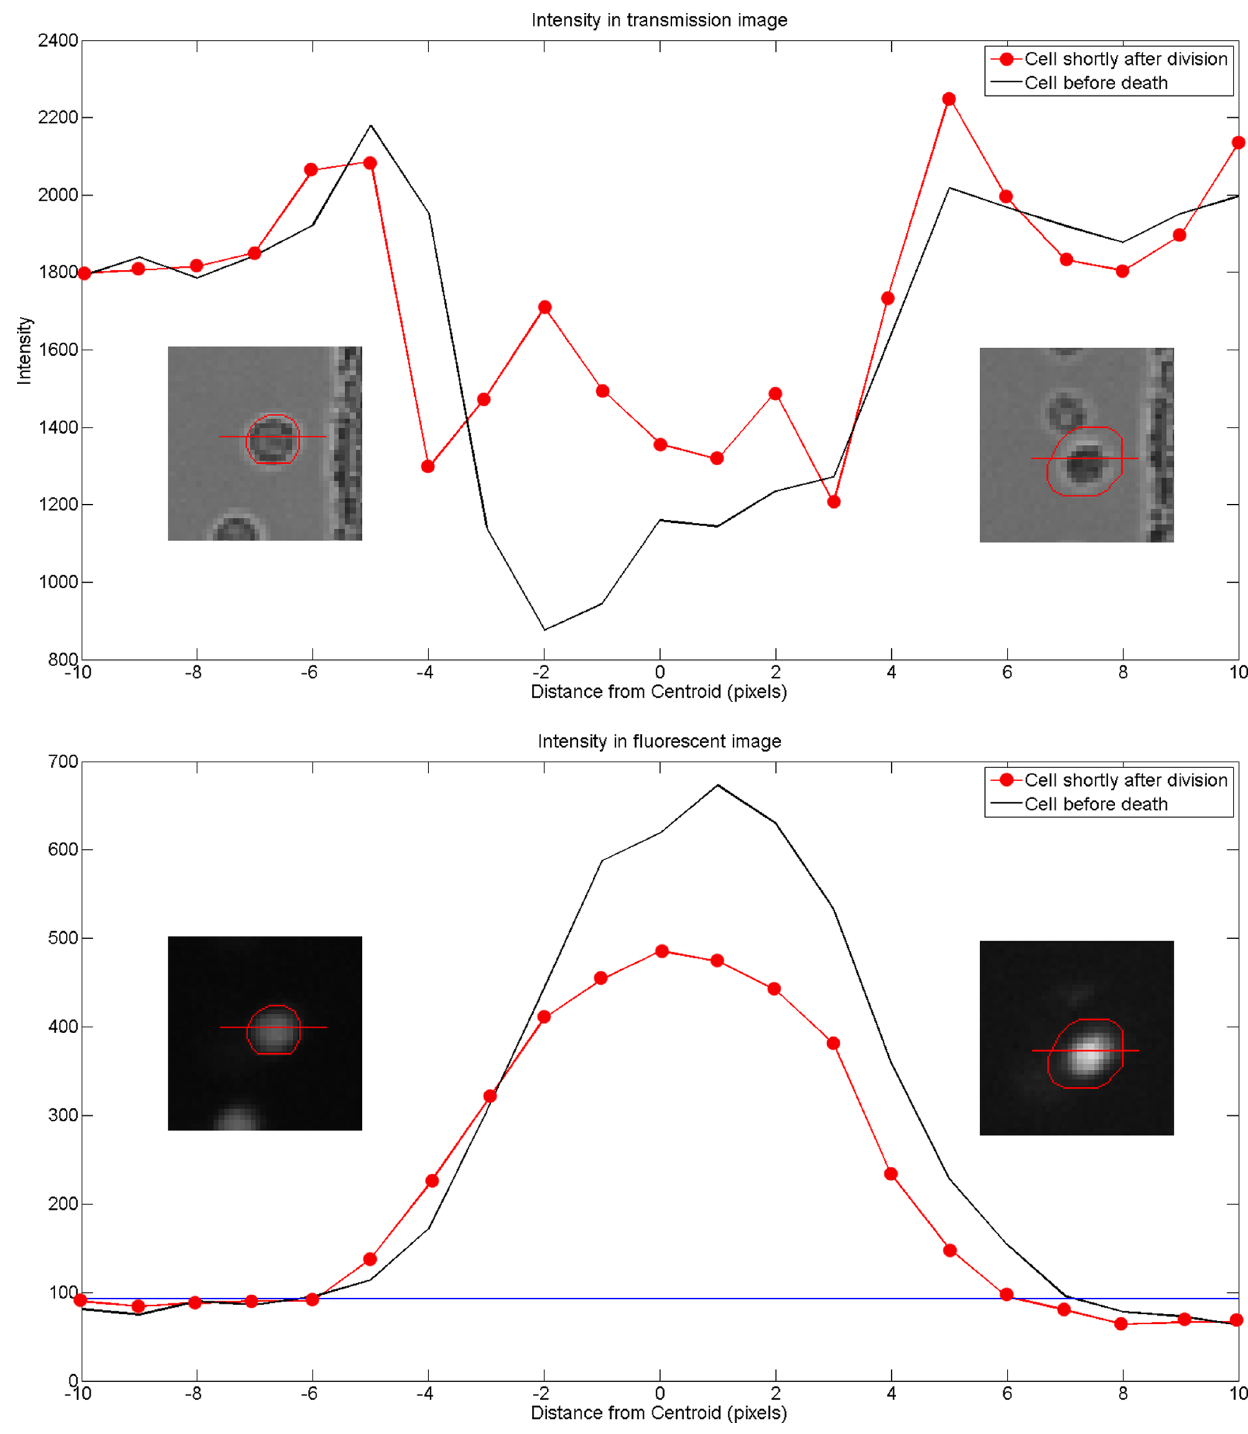
Figure 6. Systematic cell segmentation errors caused by increased fluorescence intensity in some dying cells. This data is generated from images of one cell measured having substantial growth but which eventually died rather than divide. Plotting image intensity along cell cross- sections allows more precise localization of cell boundaries. While in the transmission images growth cannot be substantiated, it is interesting that the fluorescence image shows significant increase in intensity and fluorescing area, that appears to extend beyond the boundary of the cell. The red contours were generated by TrackAssist based on difference to normalized background intensity. The dilation of the segmented area appears to be a genuine feature of the cell, but no longer representative of cell area.